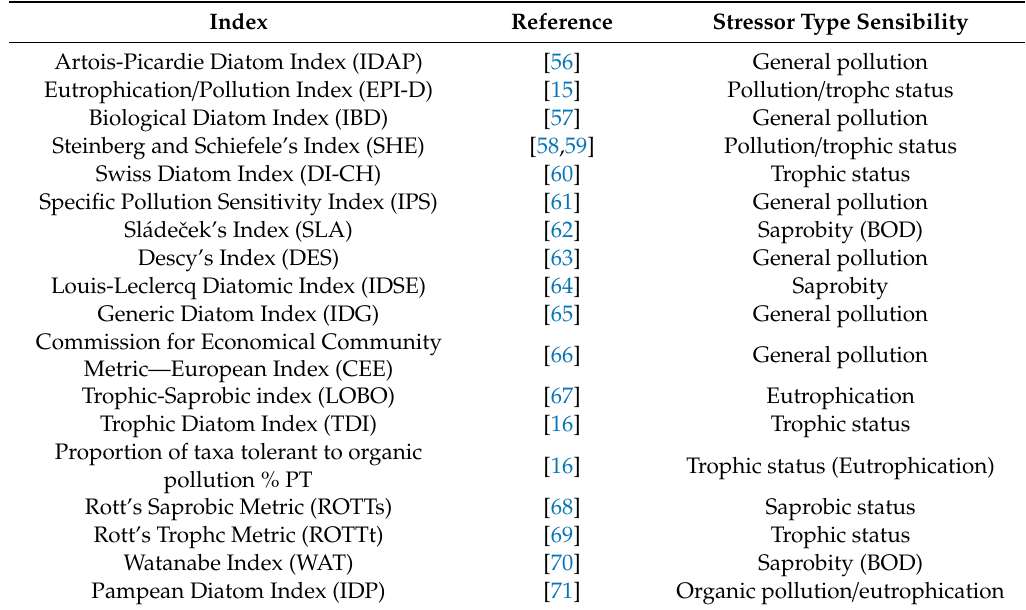
Table 1. List of diatom indices calculated for present work.